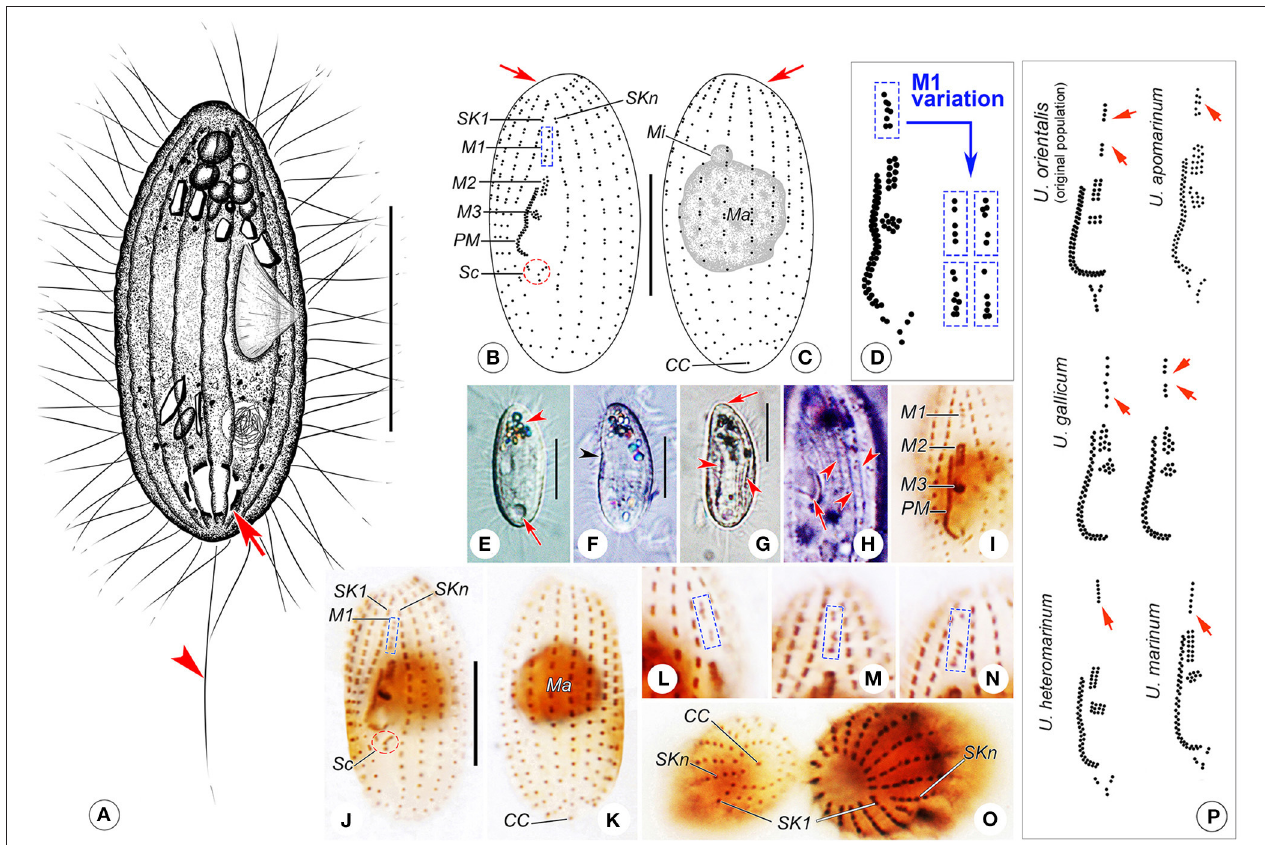
FIGURE 4 | (A–P) Uronema orientalis Pan et al., 2015 from life (A,E–H) , after protargol staining (B–D,I–O) , and comparison of the oral apparatus with that in related population/species (P) . (A) Right ventrolateral view of a representative cell, arrow shows the contractile vacuole and arrowhead points to the caudal cilium. (B,C) Ventral (B) and dorsal (C) views of a specimen with a gap in the mid-region of M1, arrows indicate the apical plate. (D) Oral apparatus of the Qingdao population of Uronema orientalis , and the variation of M1 structure. (E) Left ventrolateral view, arrow marks the contractile vacuole, arrowhead shows the clustered crystals at anterior of cell. (F) Left lateral view, arrowhead indicates the depressed buccal field on ventral side. (G) Individual with prominent depressions (arrowheads), arrow shows the apical plate. (H) Detail of pellicle, showing the buccal field (arrow) and ridges between ciliary rows (arrowheads). (I) Oral apparatus of a protargol-stained cell. (J,K) Ventral (J) and dorsal (K) views of a protargol-stained specimen, showing the ciliature and nuclear apparatus. (L–N) Variety of M1 structures that are bipartite. (O) Protargol-stained cells, revealing the structures of the posterior end (left cell) and the anterior end (right cell). (P) Comparison of oral apparatus with that in related population/species, all redrawn based on previous studies ( Uronema orientalis , original population: Pan et al., 2015a; U. apomarinum : Liu et al., 2020; U. gallicum : Pérez-Uz and Song, 1995; U. heteromarinum : Pan et al., 2010; U. marinum : Song et al., 2009), arrows point to M1. CC, caudal cilium; M1–3, membranelle 1–3; Ma, macronucleus; Mi, micronucleus; PM, paroral membrane; Sc, scutica; SK1, somatic kinety 1; SKn, somatic kinety n. Scale bars: A, E–G: 15 µ m; B, C, I–K: 10 µ